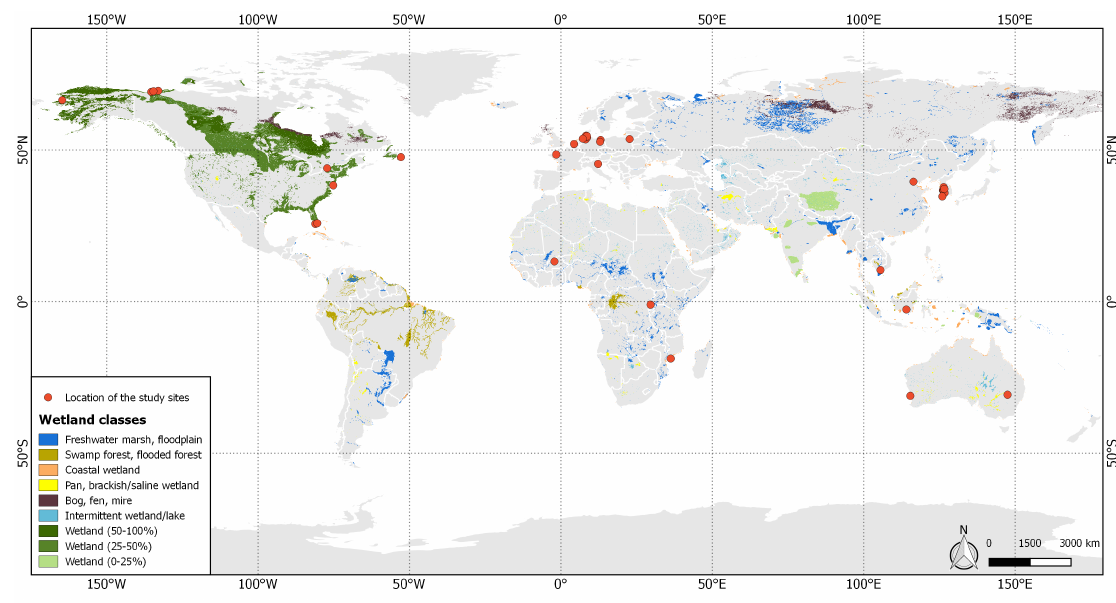
Figure 2. Generalized global distribution of wetland types based on Lehner et al. [57] and location of the study sites of published TerraSAR-X-related